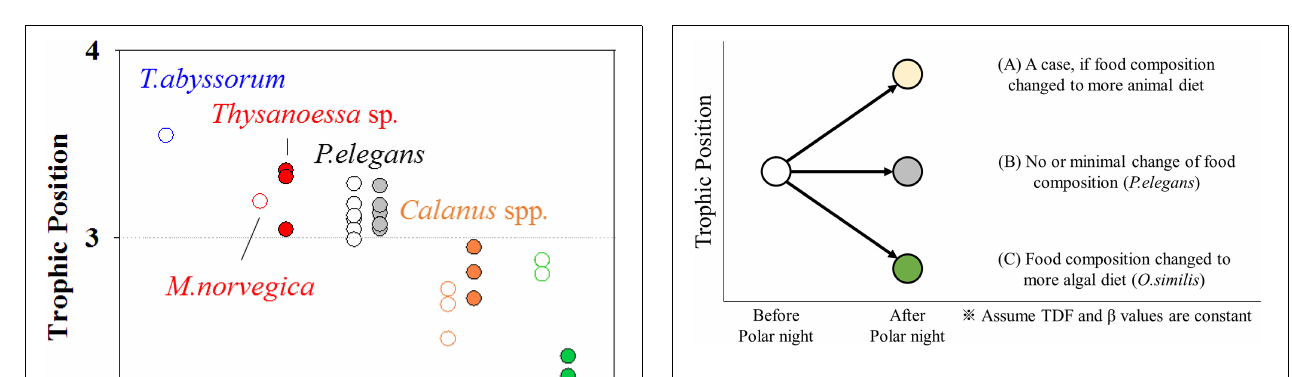
FIGURE 5 | A conceptual illustration of TP variation before and after polar night. The trophic position in zooplankton species can increase or decrease according to the change of dominant diet composition to more animal (A) or more algal diet (C), respectively. But for some carnivorous zooplankton (e.g. P. elegans ), it indicates almost constant trophic position (B) before and after polar